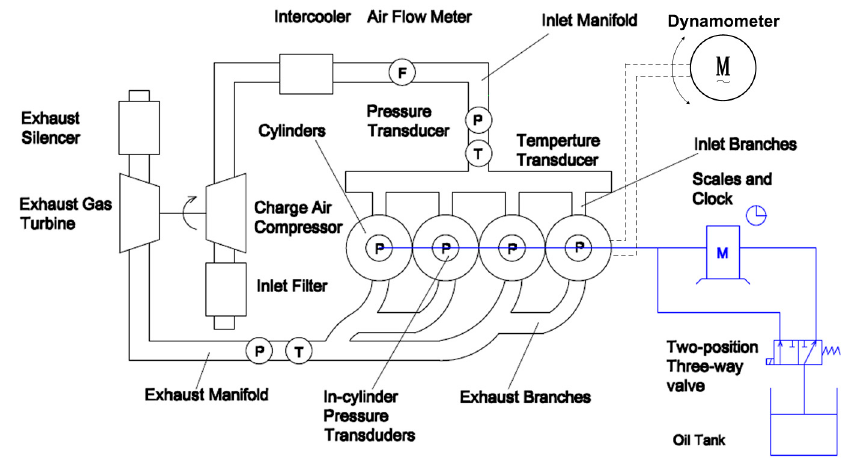
Figure 2. Schematic diagram of engine test bed layout.